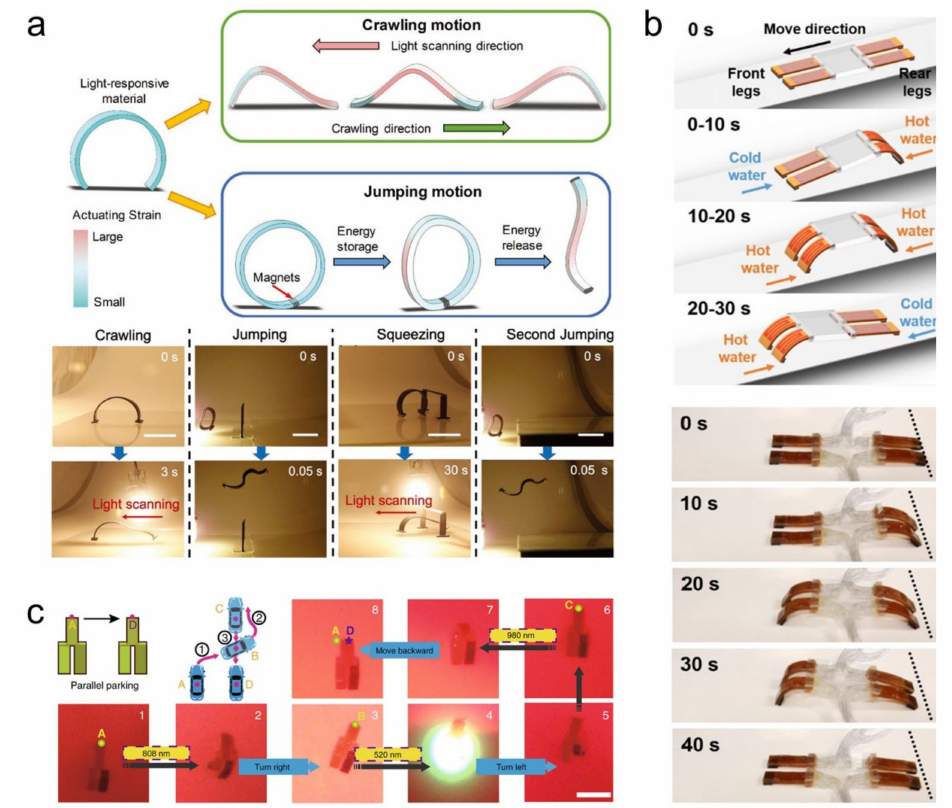
Figure 7. ( a ) Schematic illustration of the arch shape soft robot moving and crawling and jumping motion, and video frames of crawling, jumping, squeezing, and second jumping of the arch shape soft robot powered by light [36] (Reproduced with permission from Ahn, C.; Liang, X.; Cai, S., Adv. Mater. Technol.; Copyright 2019 John Wiley and Sons.), ( b ) Schematic illustration of the soft locomoting robot with automatic and programmable control, and images of the soft robot during moving [47] (Reprinted with permission from He, Q.; Wang, Z.; Wang, Y.; Song, Z.; Cai, S. Recyclable and Self-Repairable Fluid-Driven Liquid Crystal Elastomer Actuator. ACS Appl. Mater. Interfaces Schematic illustration and Photographs of the LCE walker robot parallel parking [155] (Reproduced with permission from Zuo, B.; Wang, M.; Lin, B.-P.; Yang, H.,Nat Commun; published by 2019 Springer Nature